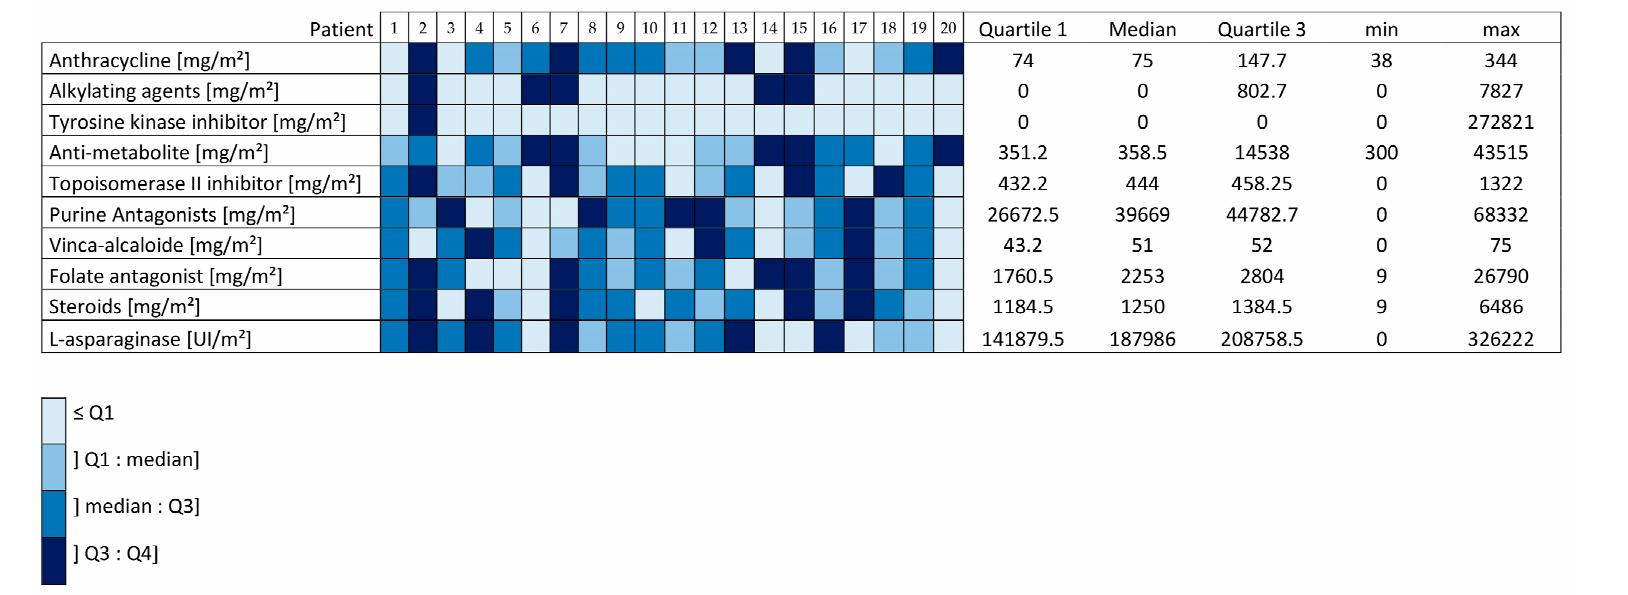
Figure 1. Cumulative chemotherapy heatmap. Alkylating agents: busulfan, cyclophosphamide, melphalan, iphosphamide; thyrosine kinase inhibitor: imatinib; anti-metabolite: cytarabine, amsacrine; topoisomerase II inhibitor: etoposide; purine antagonists: 6-thioguanine, 6-mercaptopurine; vinca-alcaloide: vindesine, vincristine; folate antagonist: methotrexate.